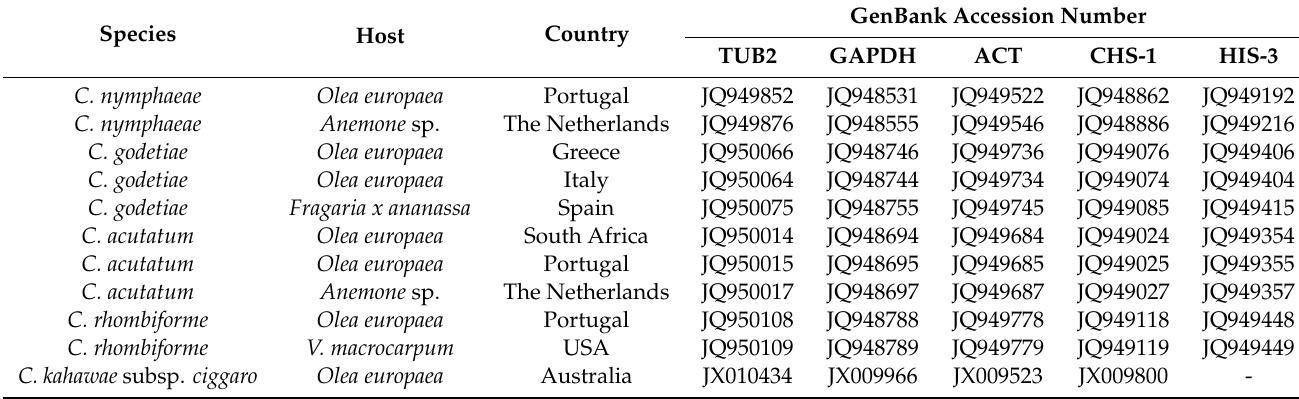
Table 3. Strains of Colletotrichum spp. used in the sequence alignments, with collection details and GenBank accession numbers. Species Host Country